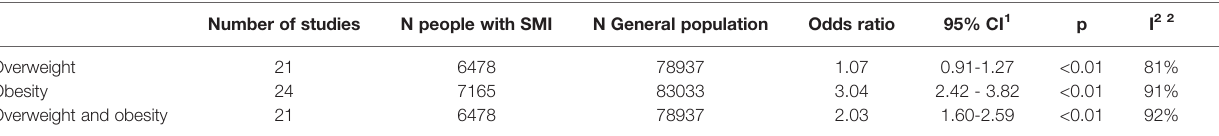
TABLE 3 | Odds of people with SMI of having overweight and obesity as compared with the general population. Number of studies N people with SMI N General population Odds ratio 95% CI 1 p I 2 2 T 2 3 Overweight 21